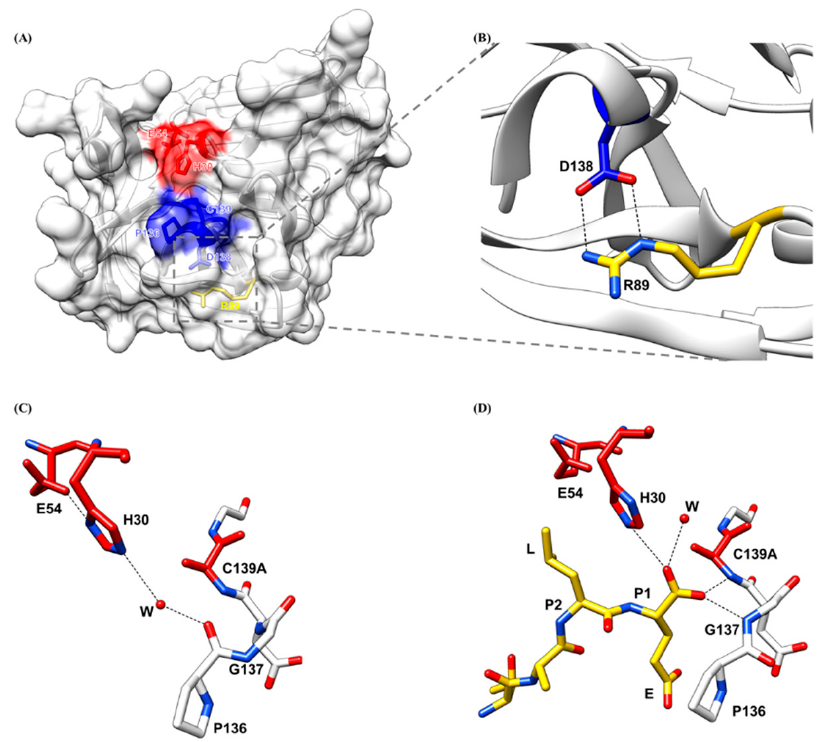
Figure 7. Oxyanion hole of the HuNoV protease. ( A ) The oxyanion hole colored in blue is next to the active site colored in red. ( B ) The amino acid residues involved in the hydrogen bonding to stabilize the oxyanion hole are colored in deep blue (Asp138) and yellow (Arg89). ( C ) In the native unbound protease, the active site colored in red interacts with the oxyanion hole colored in white through a water molecule (red sphere). ( D ) In the protease bound with a TALE substrate (yellow), the substrate interacts with the oxyanion hole colored in white though two hydrogen bonds. Oxygen and nitrogen atoms are colored in red and blue, respectively. 3. Development of Current HuNoV Protease Inhibitors The development of functional antivirals was initiated long before the detailed three- dimensional structures of the viral protease structure became available by targeting the sequences of substrate cleavage sites of the viral protease. The fundamental strategy for designing an inhibitor for a cysteine viral protease is the synthesis of a peptidomimetic inhibitor. An oligopeptide consists of two or three P residues mimicking the substrate cleavage site with a reactive warhead linked to P1 residue, which will form a covalent bond with the active Cys residue to abolish the protease enzymatic activity. This strategy has been proven to be successful in blocking the rhinovirus cysteine viral protease in vivo when the inhibitor is linked with a C-terminal Michael acceptor group [80]. The first re- ported HuNoV protease inhibitor complex structure [66] denoted the interaction between the Southampton protease and a substrate-based inhibitor mimicking the EFQLQ se- quence of the protease cleavage site linked with a C-terminal Michael acceptor group. The interactions are primarily via a hydrogen-bonding network in the form of an antiparallel β -sheet in the substrate-binding pocket. The design of a linear di-peptide or a tri-peptide peptidomimetic inhibitor is then adopted as a structural backbone for in-lab-synthesized HuNoV protease inhibitors that could be further transformed into molecules possessing important pharmacodynamic and pharmacokinetic properties by primarily modifying the